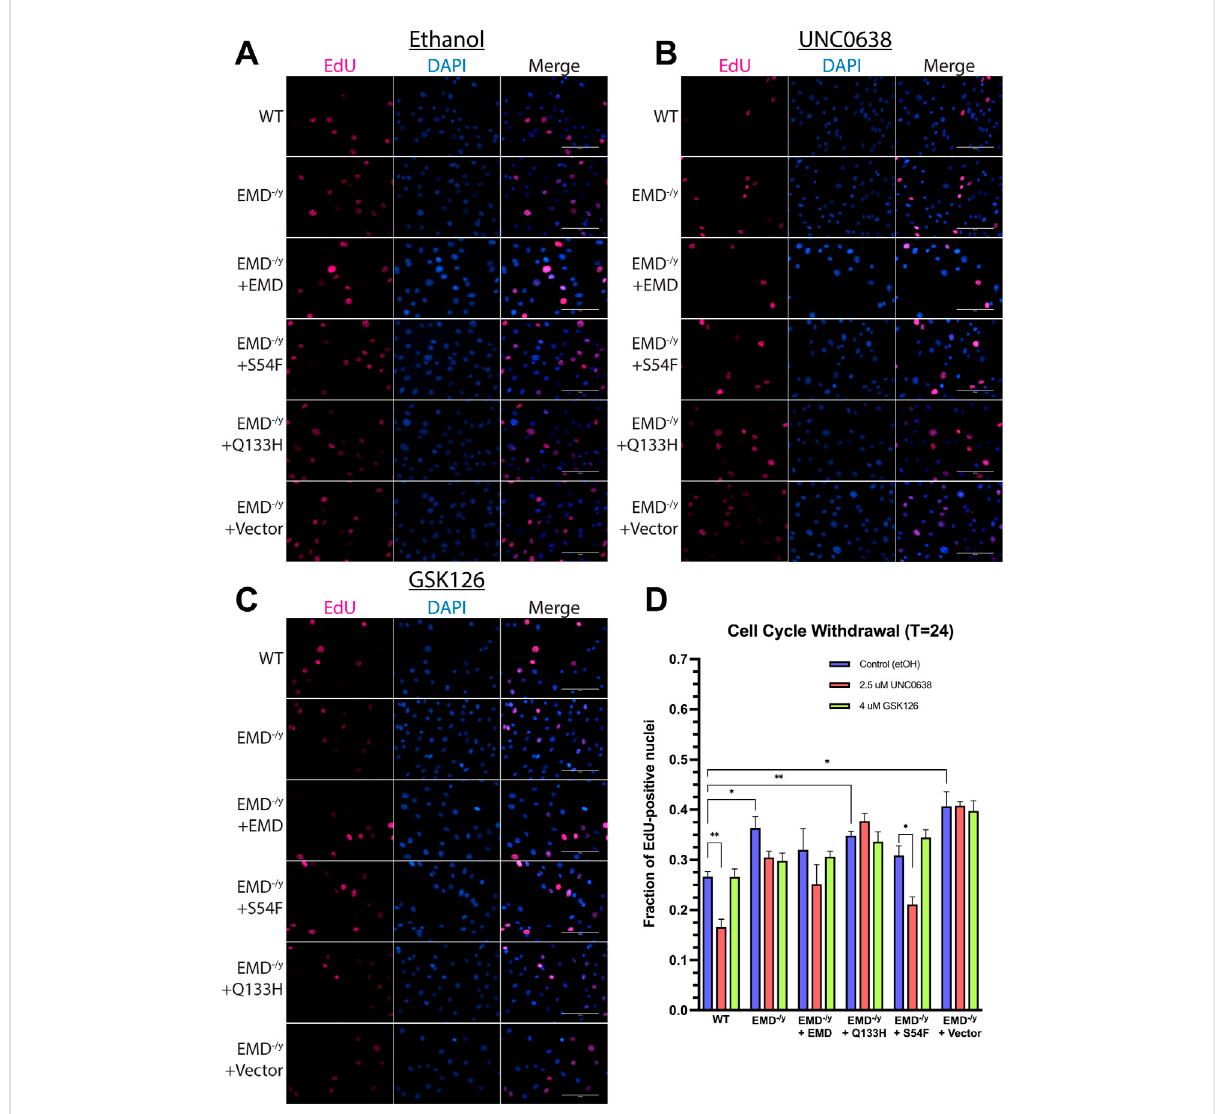
FIGURE 5 UNC0638 and GSK126 treatment fails to rescue impaired cell cycle withdrawal of emerin-null, S54F, and Q133H myogenic progenitors. The indicated myogenic progenitor cell lines were induced to differentiate in the presence of ethanol alone (A) , UNC0638 (B) or GSK126 (C) for 24 h. Cells were incubated with EdU for 2 h prior to fi xing and imaging to monitor cell cycle withdrawal. EdU-positive cells were counted and plotted [ (D) ; n > 225 for each cell line]. Scale bars represent 100 μ m. Error bars represent SEM. (Student ’ s t-test; *p < 0.05 **p <